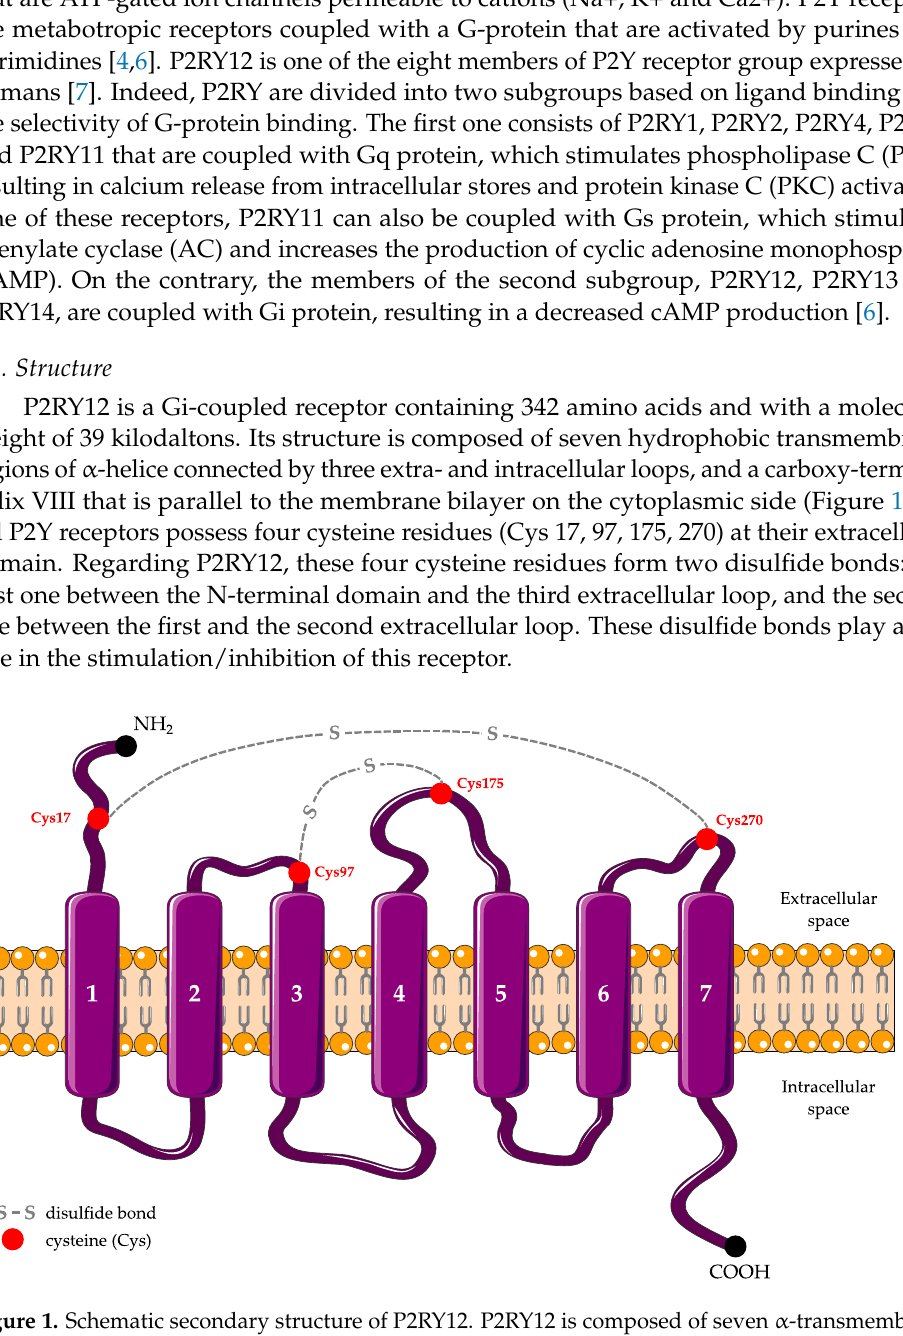
Figure 1. Schematic secondary structure of P2RY12. P2RY12 is composed of seven α -transmembrane domains connected by three extra- and intracellular loops. There are four extracellular cysteines (Cys) at positions 17, 97, 175, and 270 that form two disulfide bonds. It is noteworthy that there is a marked difference between the agonist and the antag- onist bound receptor structure. Indeed, when P2RY12 is activated, the receptor binding